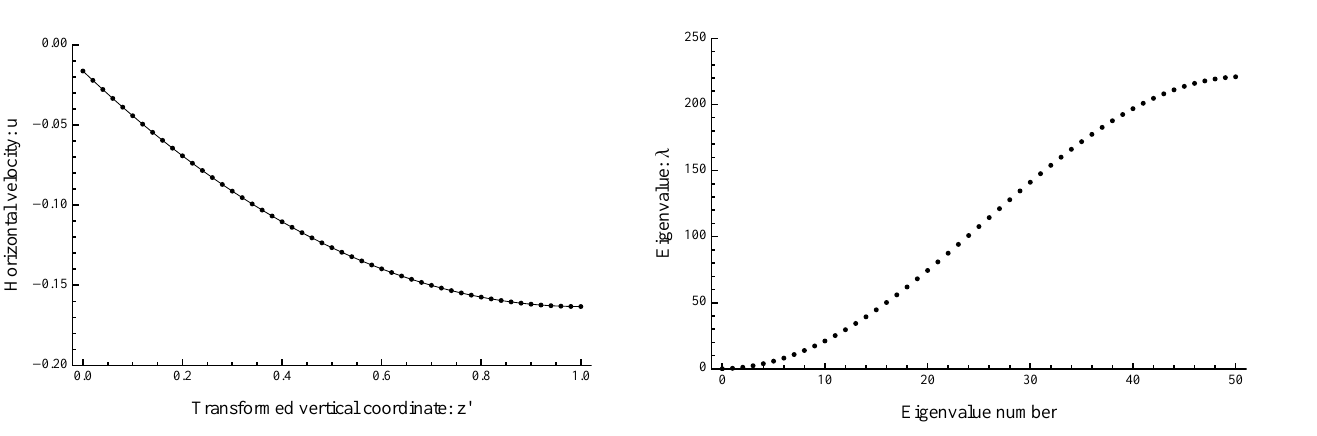
Fig. 5. The eigenvalue spectrum for the reformulated Stokes sys- tem, Eq. (58).